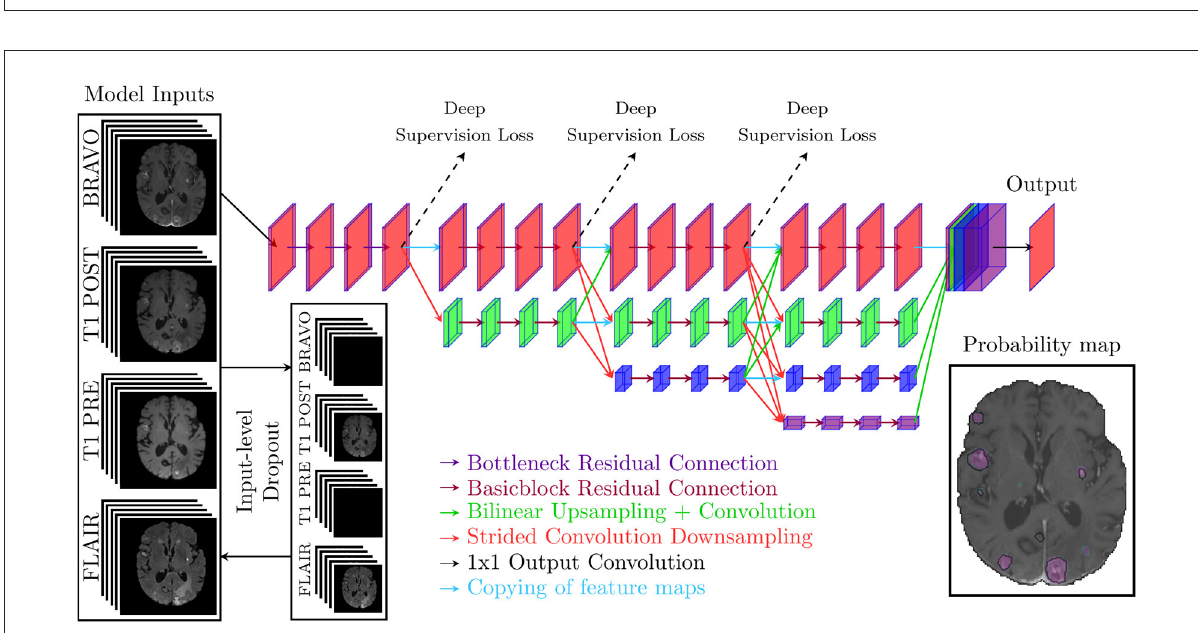
FIGURE2 The general model architecture that takes either five slices from one to four sequences as inputs for the 2.5D model or a volume from one to four sequences for the 3D model. For the 2.5D model, the inputs are upscaled with bilinear upscaling before downsampling through a convolutional operation. The model prediction is a probability map between 0 and